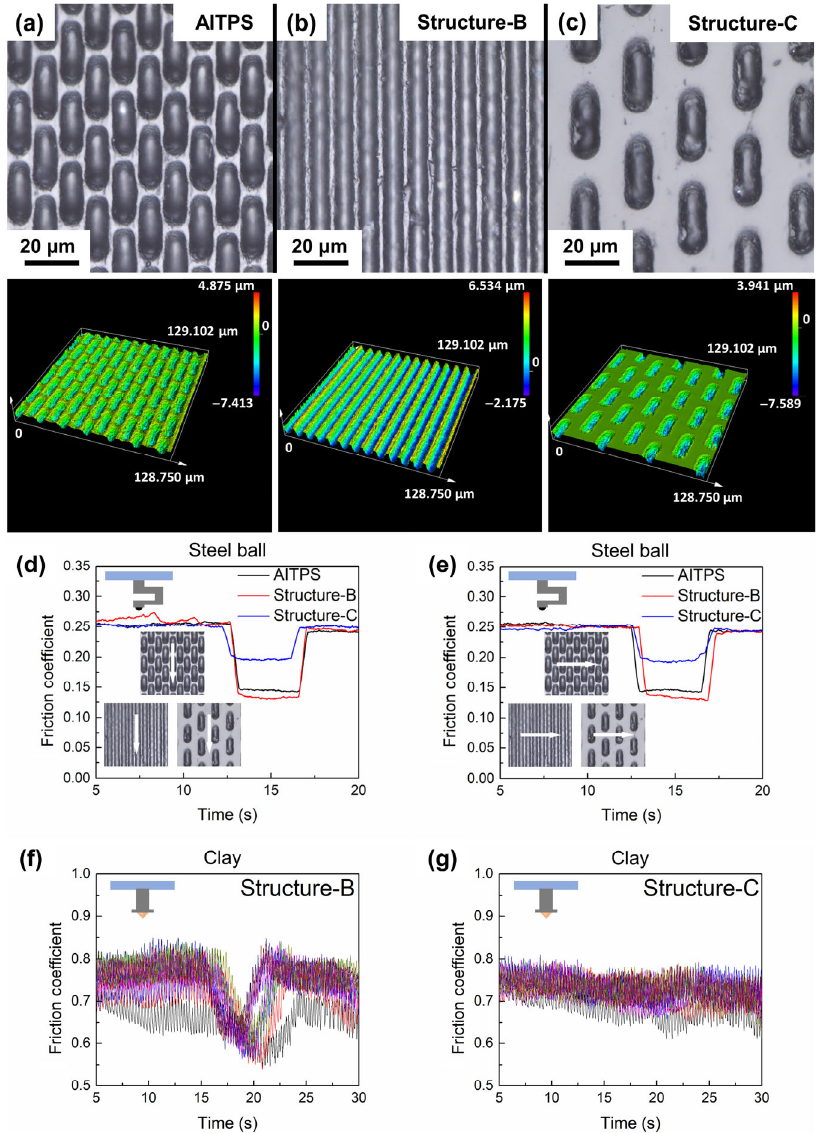
Fig. 5 (a–c) LEXT images of AITPS, Structure-B, and Structure-C; (d, e) friction coefficient curves of three patterned surfaces in longitudinal and lateral directions in contact with smooth steel ball, respectively; and (f, g) friction coefficient curves of Structure-B and Structure-C after 10 times of measurements in contact with commercial clay,